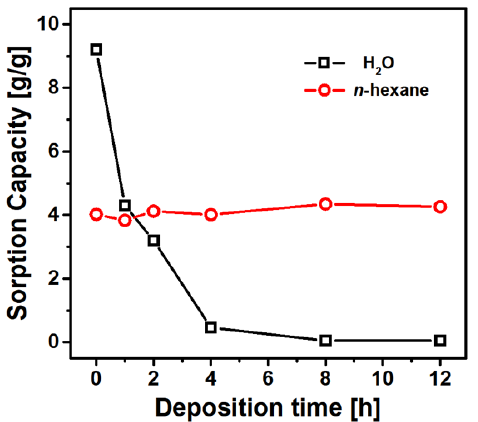
Figure 5. Variations of sorption capacity as a function of PDMS deposition time for water and n - hexane.